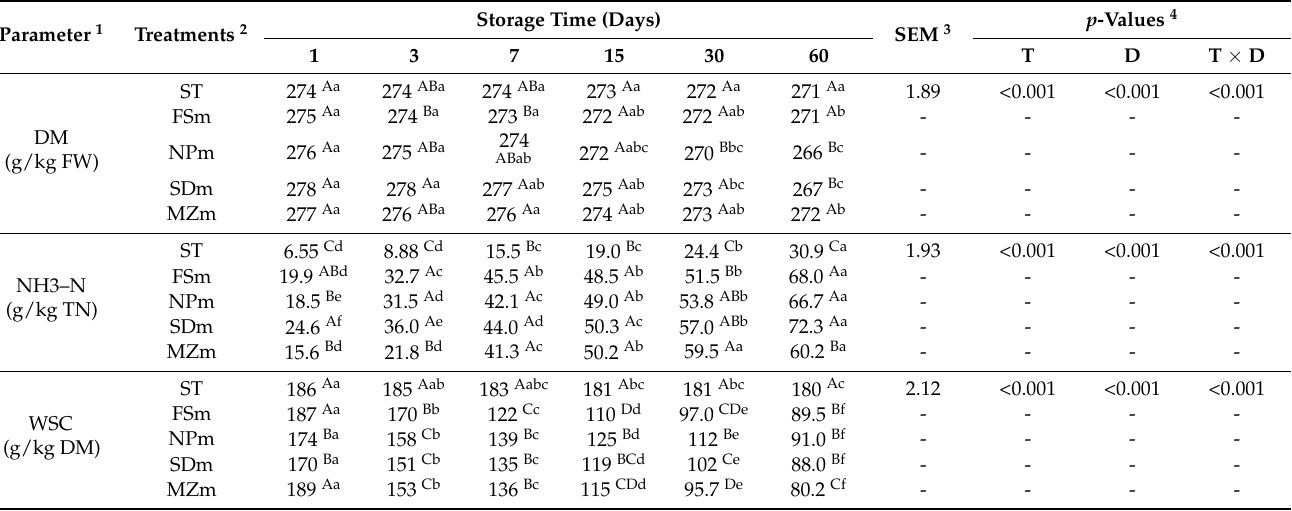
Table 4. Dynamics of chemical composition and NH 3 –N concentrations during 60 days ensiling of forage sorghum silage.